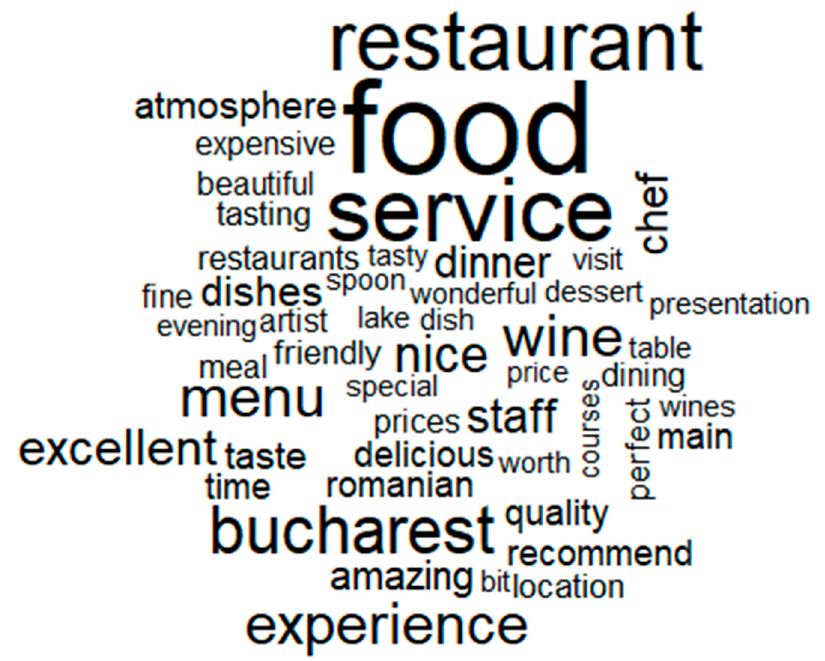
Figure 1. Word cloud analysis for the whole period for all five restaurants.